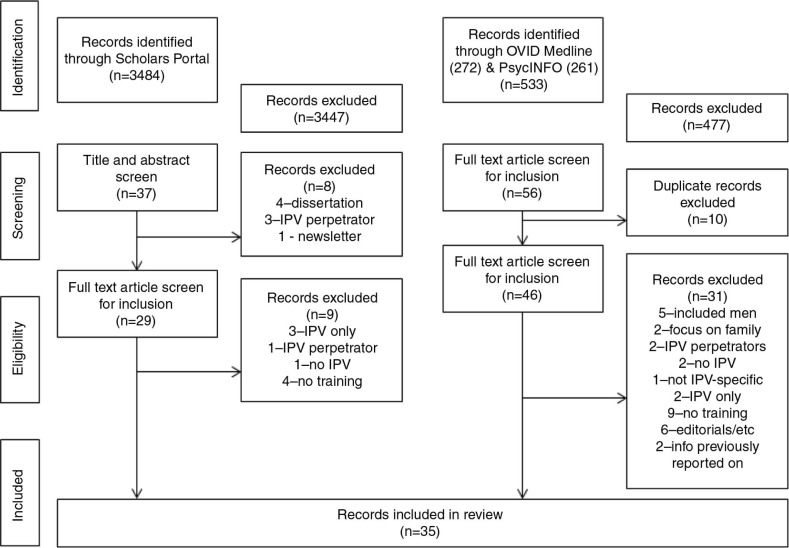
Records reviewed.